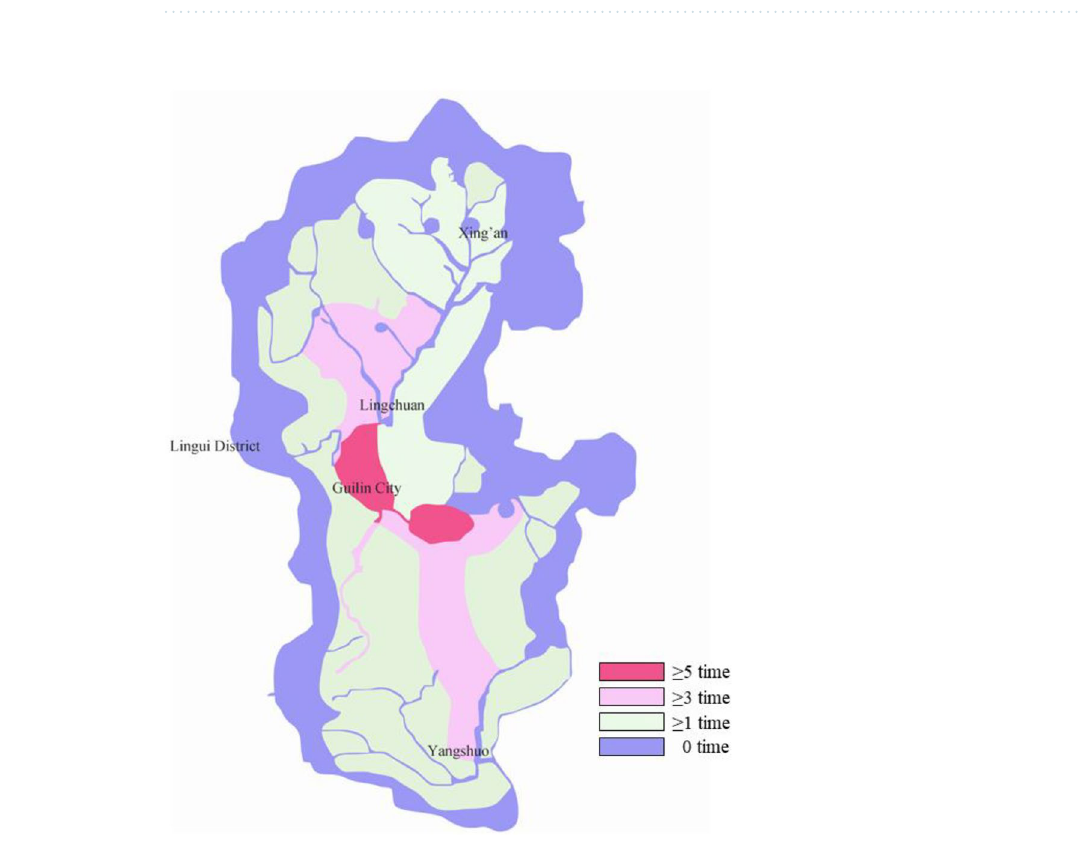
Table 6. Overview of historical floods in Lijiang River basin.